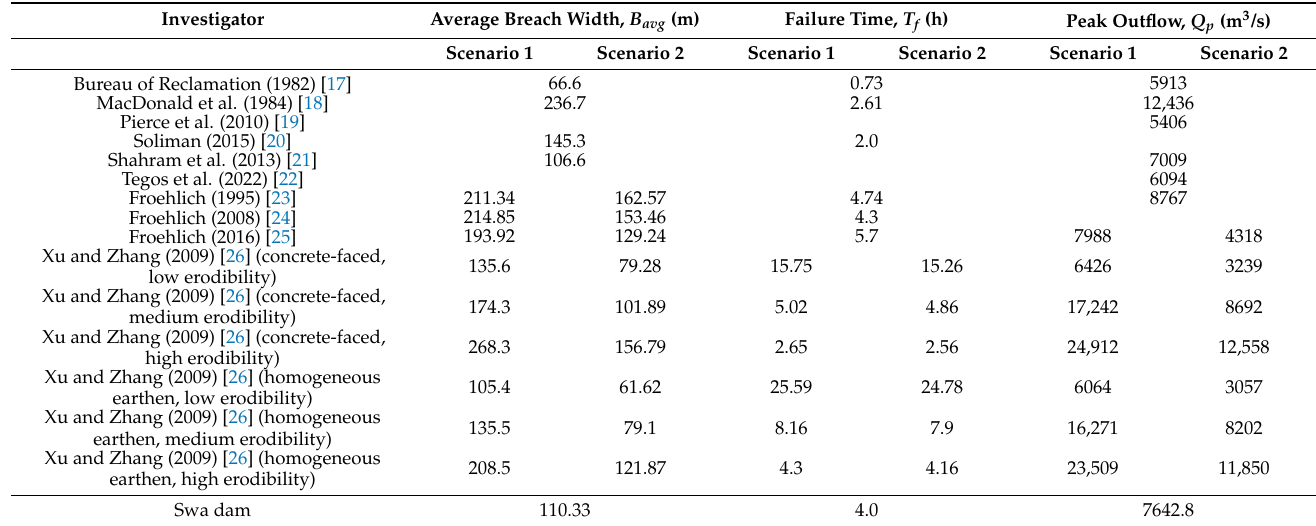
Table 3. Comparison of calculated results and observed data for Scenarios 1 and 2.